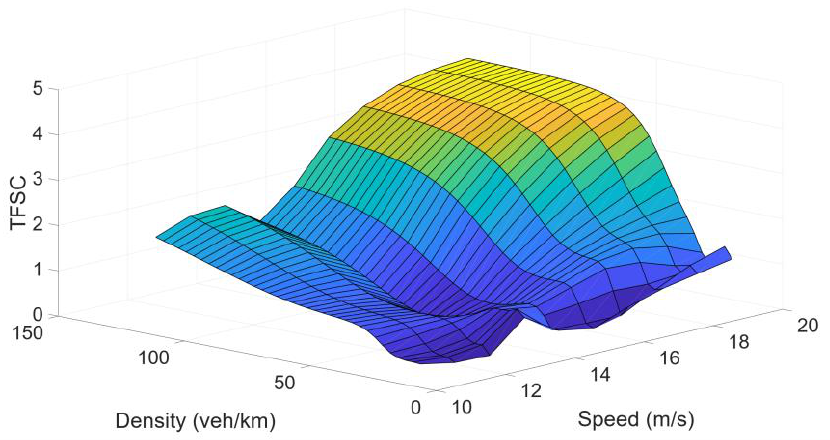
Figure 13. Neural network fitting results of TFSC for traffic speed and density.